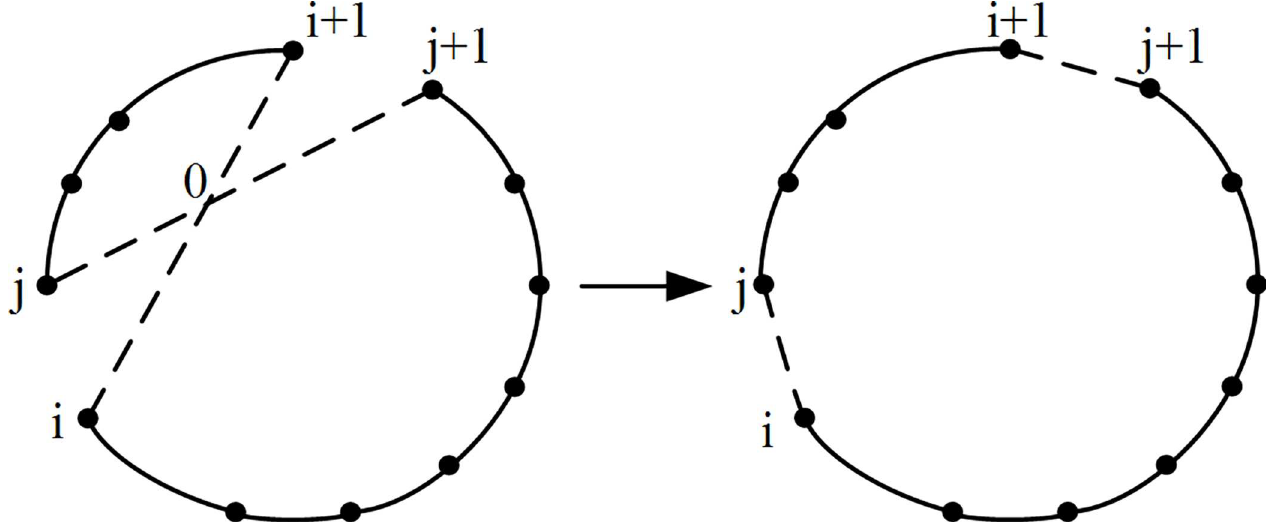
Fig 3. Edge intersection elimination